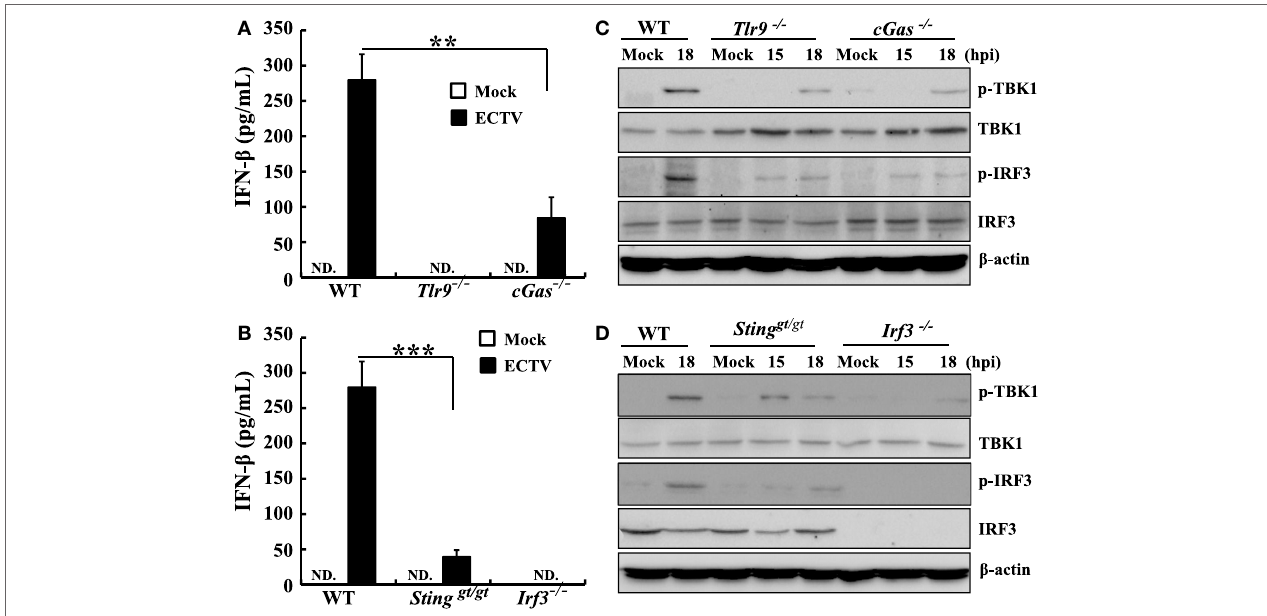
FigUre 5 | Murine peritoneal macrophages response ectromelia virus (ECTV) infection was dependent on Tlr9 and cGas–Sting–Irf3 pathway. Peritoneal macrophages generated from wild-type (WT), cGas − / − , Sting gt/gt , Tlr9 − / − , and Irf3 − / − mice were non-infected or infected with ECTV at an MOI of 5. Supernatants were collected 18 h post-infection (hpi) for determining the concentrations of IFN- β by using enzyme-linked immunosorbent assay (ELISA) (a , B) , and cells were collected at 15 and 18 hpi for western blot analysis using anti-phospho-Tbk1, anti-Tbk1, anti-phospho-Irf3, and anti-Irf3 (c , D) . β -Actin was used as a loading control. The ELISA data were averaged from two independent experiments in biological triplicate. Results of western blot analysis shown are representative of two independent experiments. The data were analyzed using a t -test on SPSS software. In this figure, ND, not detected; ** P ≤ 0.01 and *** P ≤